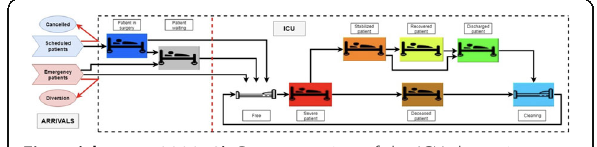
Fig. 1 (abstract 000052). Representation of the ICU dynamics through the change of bed's